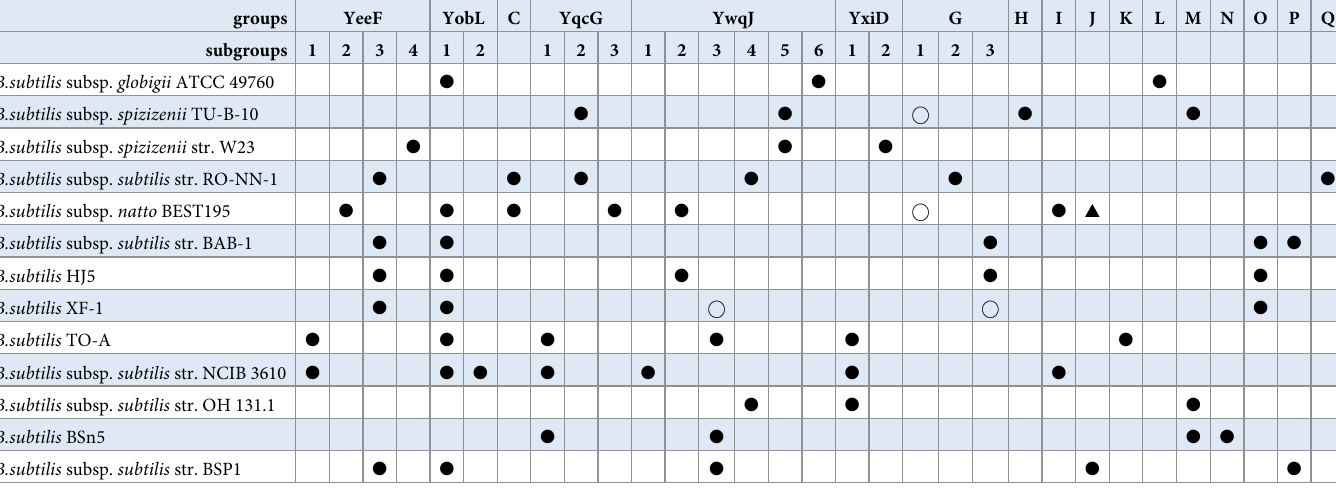
Table 1. Classification and distribution of LXG toxin and antitoxin genes in B . subtilis strains a) .